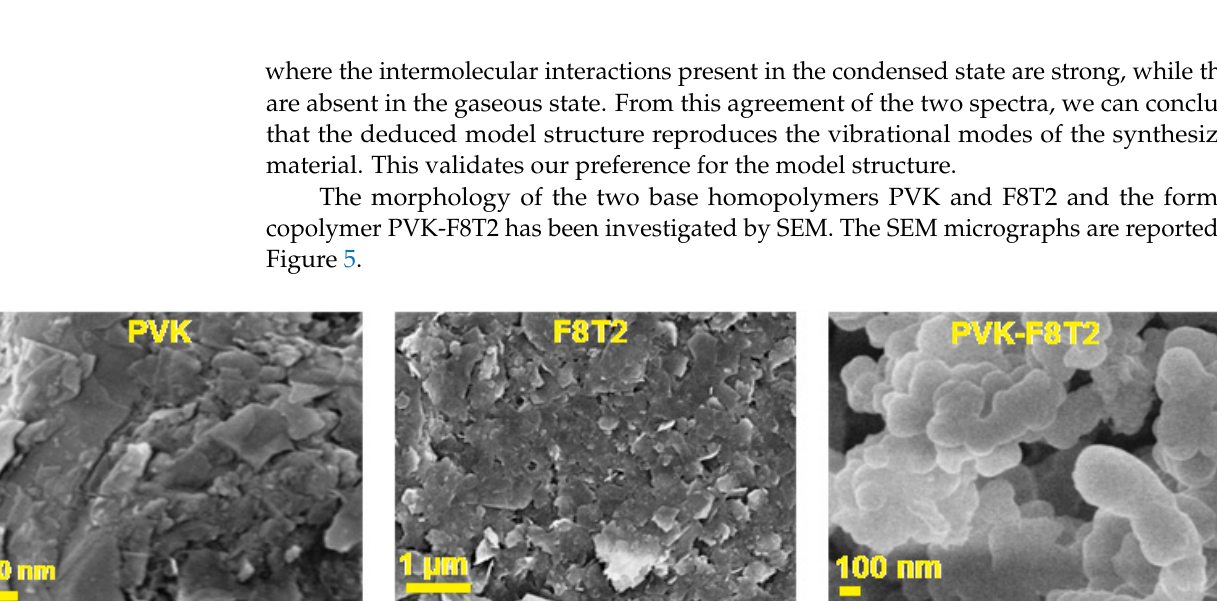
Figure 4. Experimental and simulated infrared spectra of PVK-F8T2.